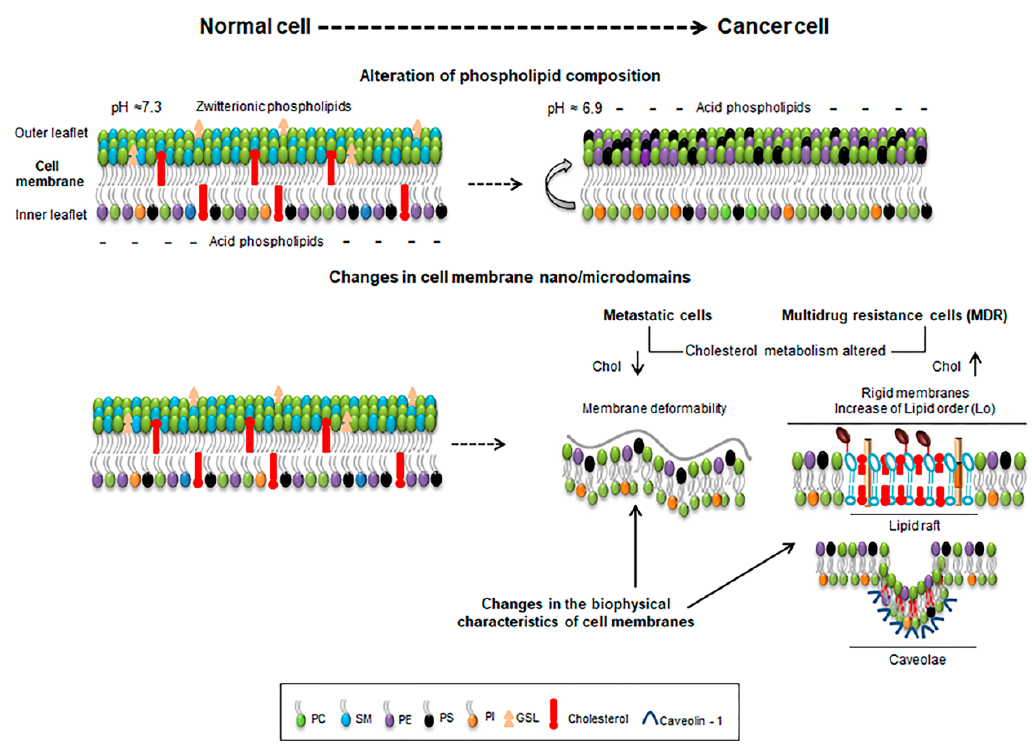
Figure 1. Schematic representation of some features of normal and cancer cells depicting lipid composition and extracellular pH (upper panel), and the alterations occurring at the cellular membrane nano/microdomains (lower panel). Metastatic cells with lower cholesterol levels (chol ↓ ) enhance membrane deformability (lower panel, left) while cells with increased cholesterol levels (chol ↑ ) enrich membrane in ordered lipid raft domains and rigidity (lower panel, right).